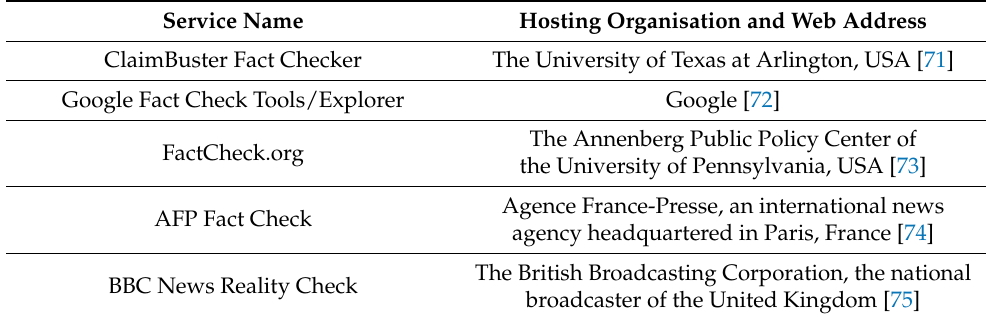
Table 2. Examples of online COVID-19